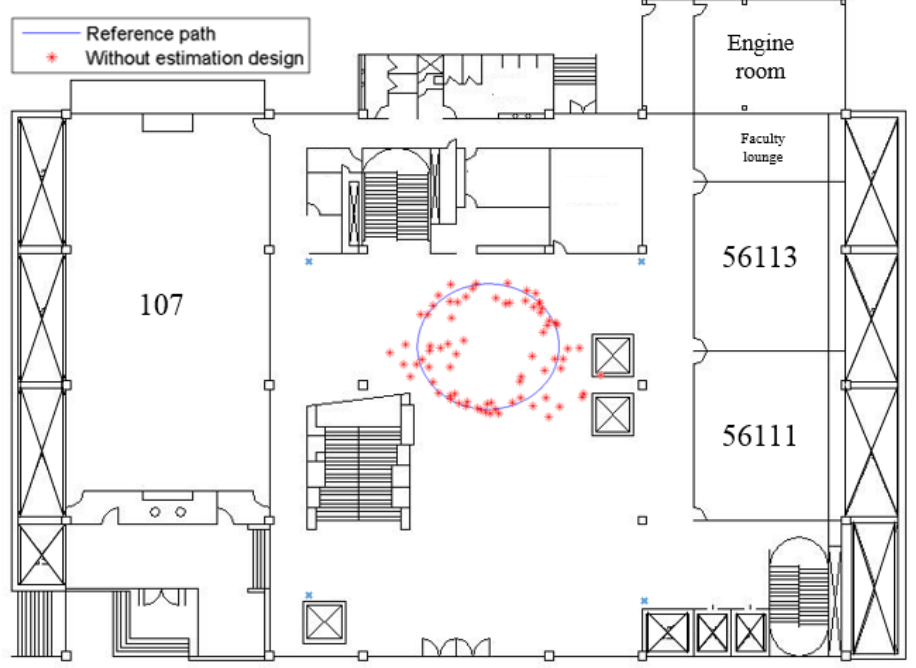
Figure 15. The indoor positioning result without any estimation design.